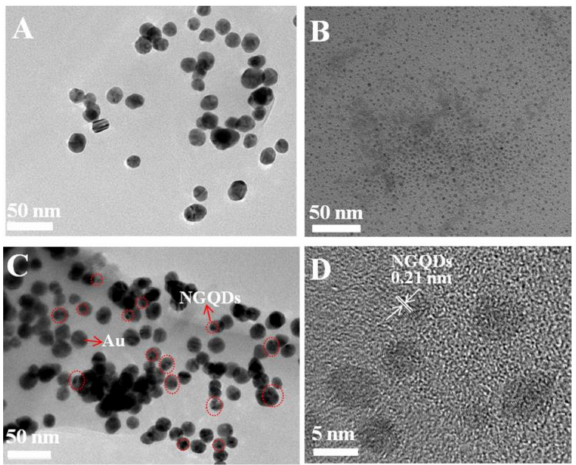
Figure 1. TEM images of ( A ) Au, ( B ) nitrogen-doped graphene quantum dots (NGQDs), and ( C ) Au / NGQDs. HRTEM image of ( D )